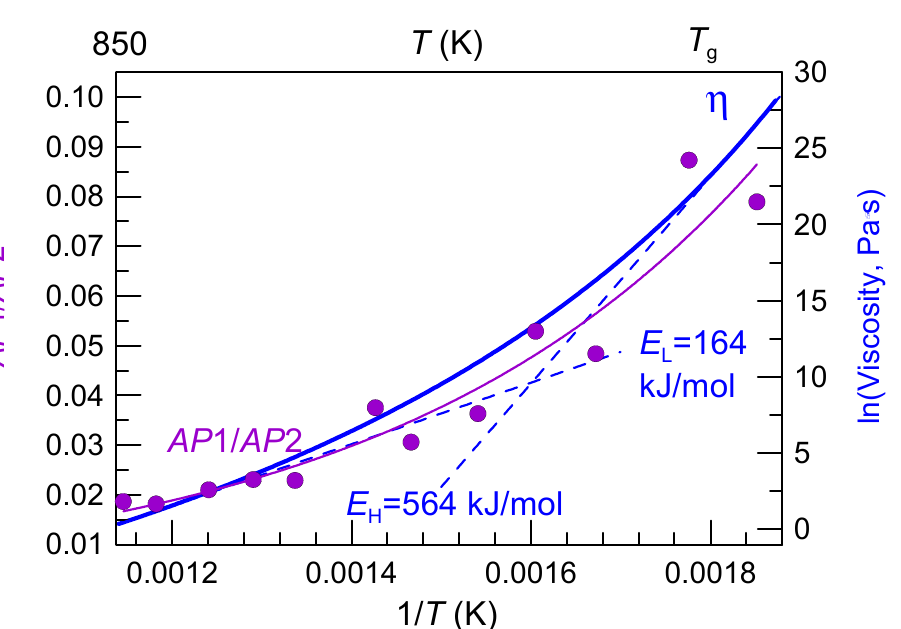
Figure 7. The ratio of the area under the first Cu,Ni-P PDF ( R ) peak ( AP 1) and second Pd-Pd PDF ( R ) peak ( AP 2) of the Pd 42.5 Cu 30 Ni 7.5 P 20 glass-forming alloy as a function of inverse temperature (violet circles) and fitting with an exponential growth function y = y 0 + e (x–x0/C) (violet line) where x is 1/ T . The data are from Ref. [136]. Solid blue line represents natural logarithm of viscosity as a function of 1/ T while dashed blue lines represent the activation energies obtained in high ( E H ) and low ( E L ) temperature areas. The data are taken from Ref. [136].